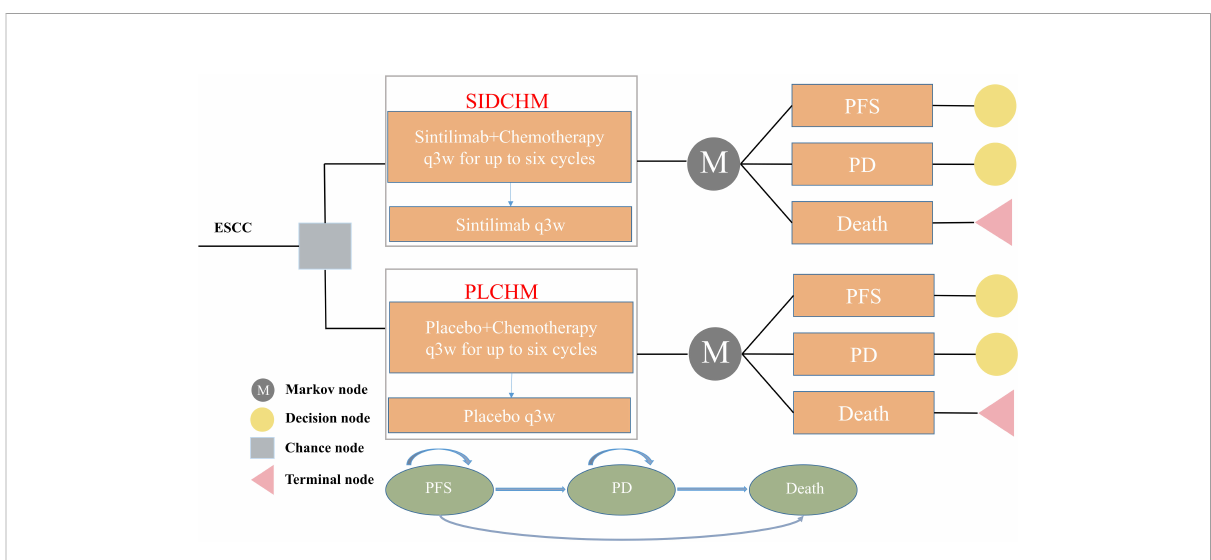
FIGURE 1 The Markov model simulates outcomes for the ORIENT-15 trial. All patients with ESCC started with PFS state and received treatment with SIDCHM or PLCHM. ESCC, esophageal squamous cell carcinoma; PD, progressive disease; PFS, progression-free survival; PLCHM, placebo plus chemotherapy; SIDCHM, sintilimab plus